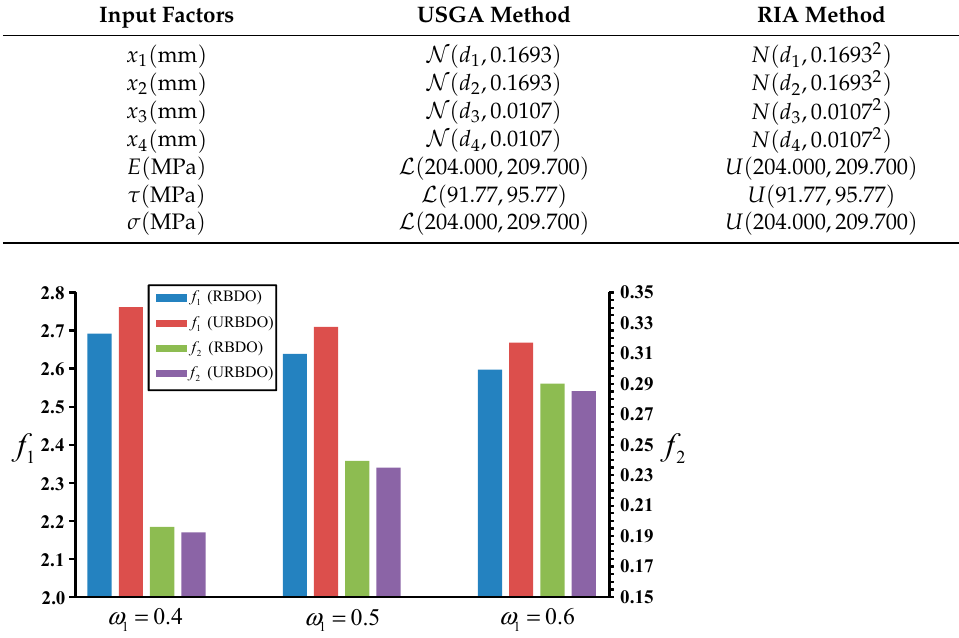
Figure 10. Comparison of optimal results under different weights. Table 6. Solution results under different weight coefficients for the welded beam